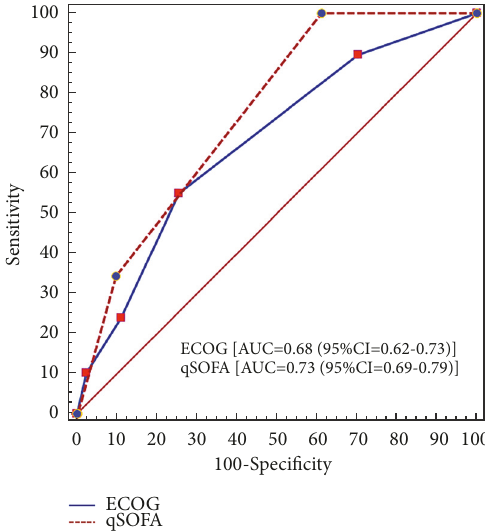
Figure 2: Survival probabilities in postsurgical cancer patients without infection, according to the quick sequential organ failure assessment (qSOFA)